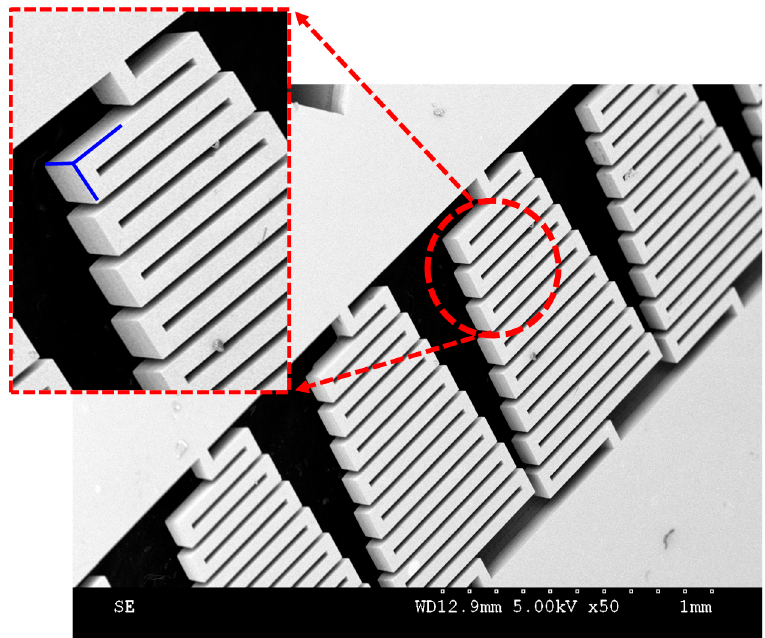
Figure 4. SEM photograph of awl ‐ shaped serpentine microsprings.